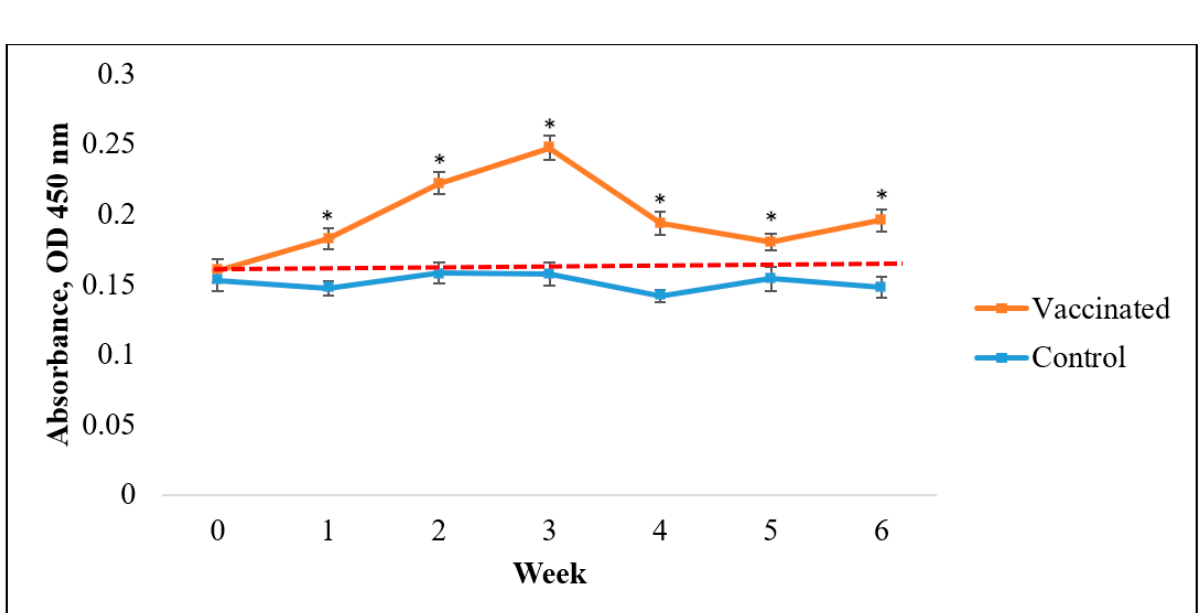
Figure 7. Specific antibody (IgM) levels against A. hydrophila in vaccinated Asian seabass (mean ± SE, n = 6) 6 weeks post ‐ vaccination. Asterisks indicate a significant difference ( p < 0.05) from the control.